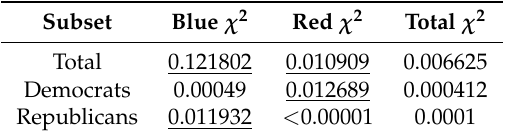
Table 7. The p -value associated with each of these is based on the cumulative distribution function (CDF), namely p = 1 − CDF . At a significance level of 0.01, the non-significant deviations are